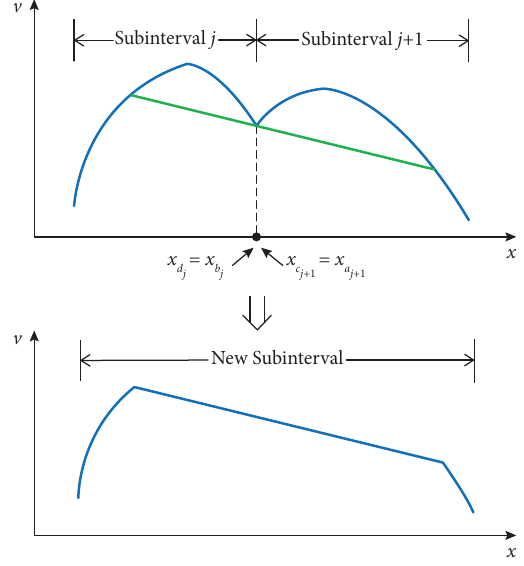
Figure 6: Te illustration of the subinterval